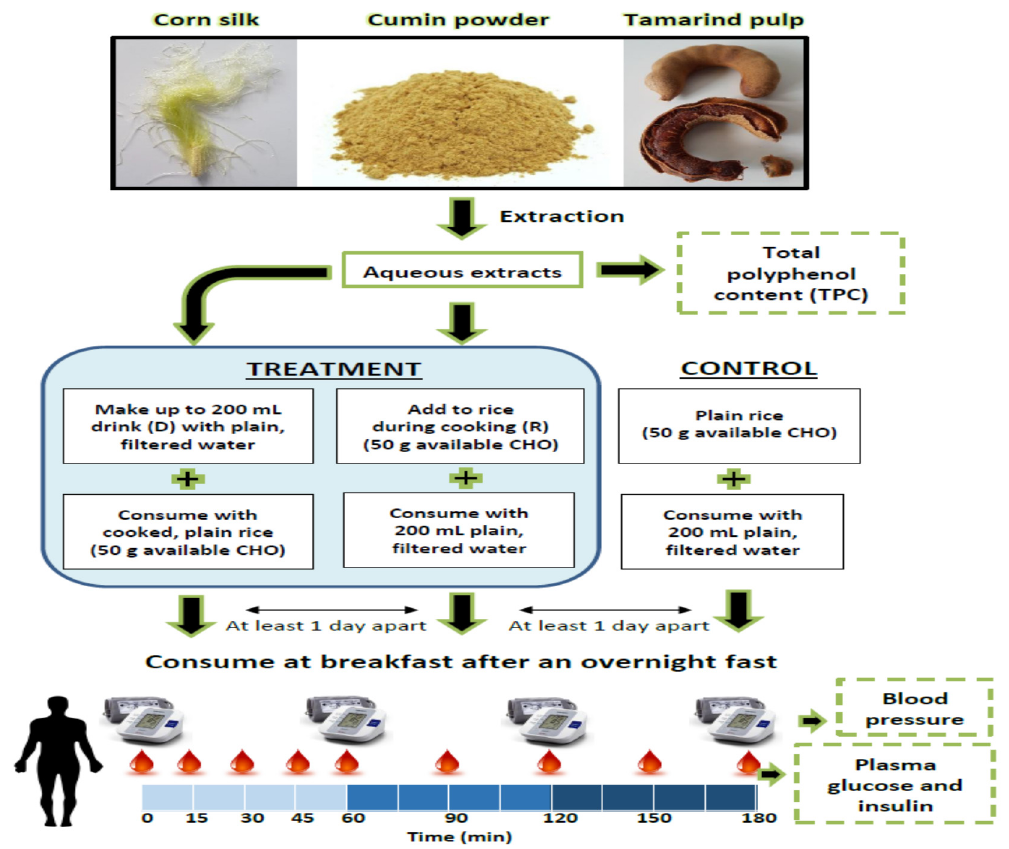
Figure 1 . Schematic of study design. Figure 1. Schematic of study